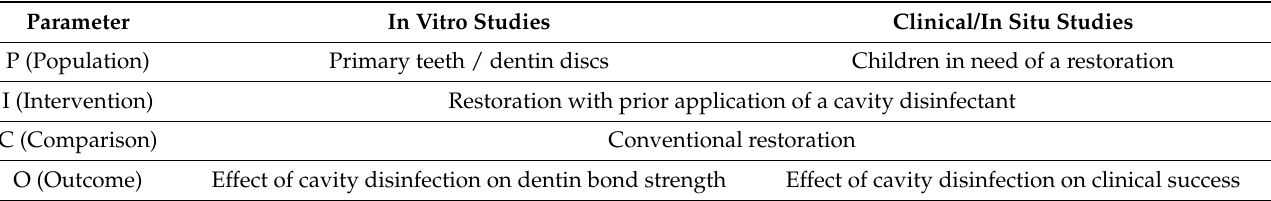
Table 3. Problem, Intervention, Comparison, Outcome (PICO) strategy.